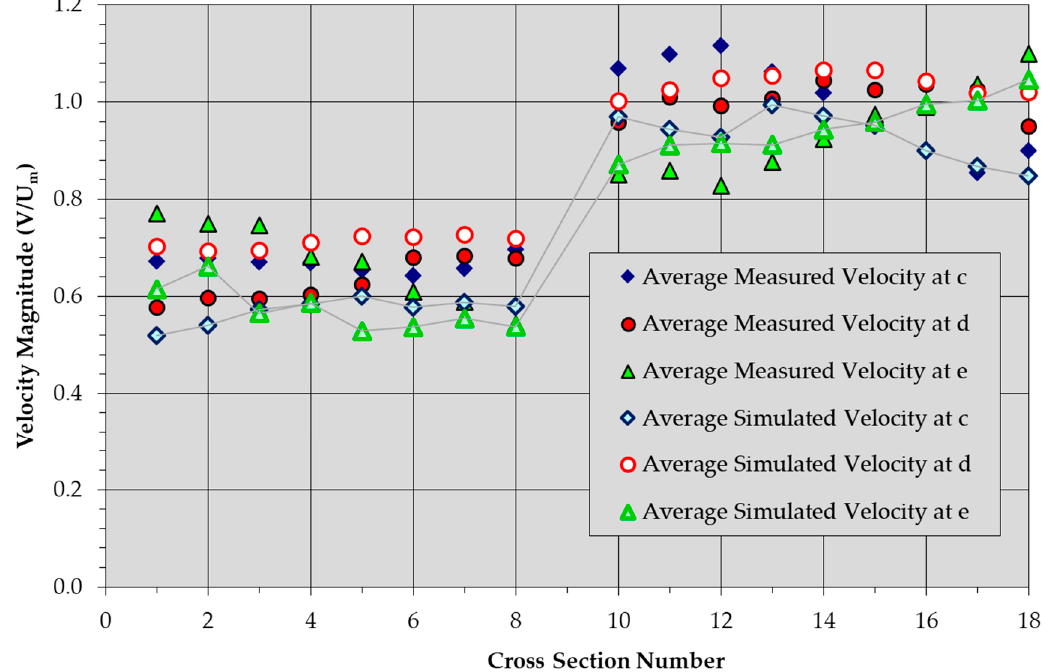
Figure A13. Simulated and measured depth-averaged, stream-wise velocities are compared using a 3D model mesh size of 492 × 42 × 32. Measurement locations “c” and “e” are at the toe of the left and right channel banks. Measurement location “d” is at the channel center.